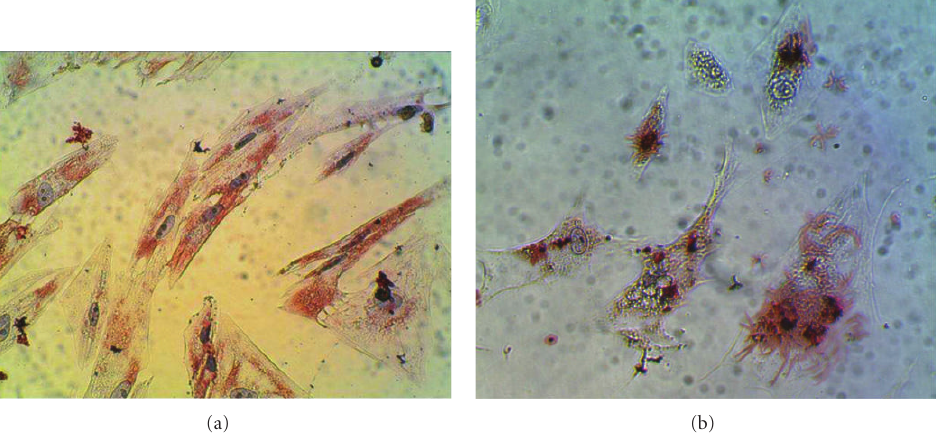
Figure 7: Adipogenic di ff erentiation. Oil Red O staining of adipogenic di ff erentiation of UC-MSCs (a) with formation of smaller lipid vacuoles and of BM-MSCs (b) with formation of large